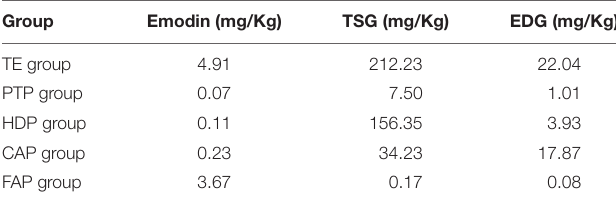
TABLE 6 | The dosage of the three compounds in different part of PM administered for